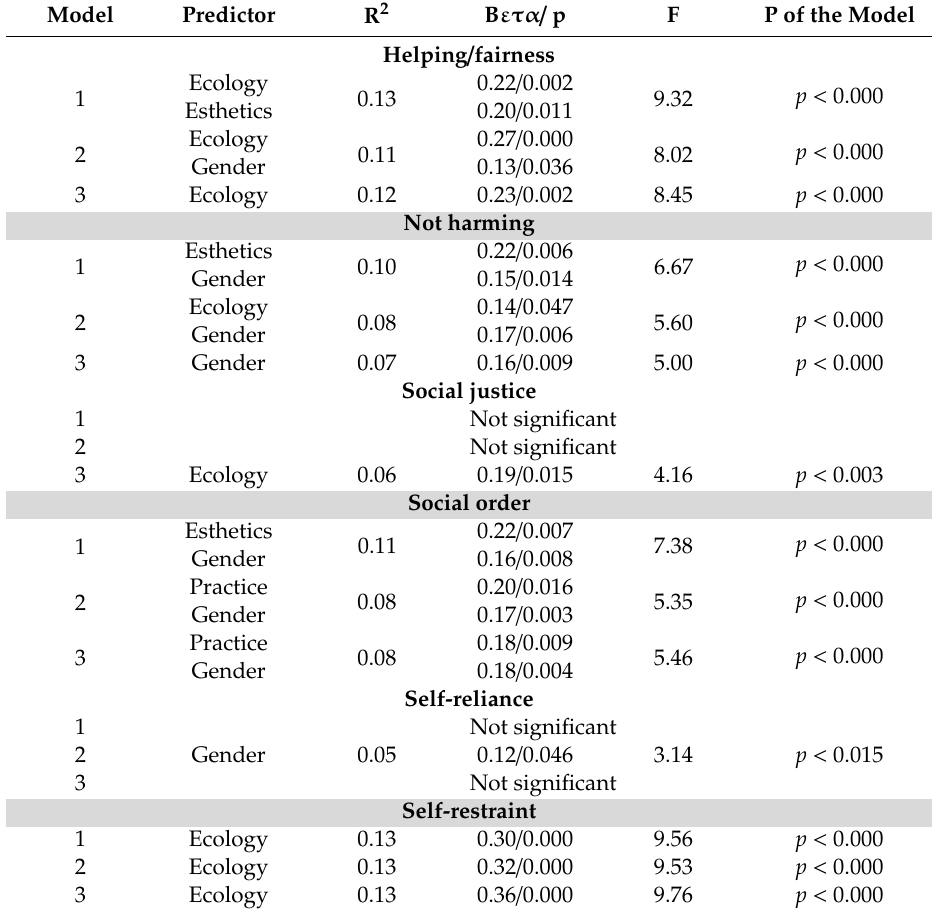
Table 3. Predictive validity of the attitudes toward the plant world for moral